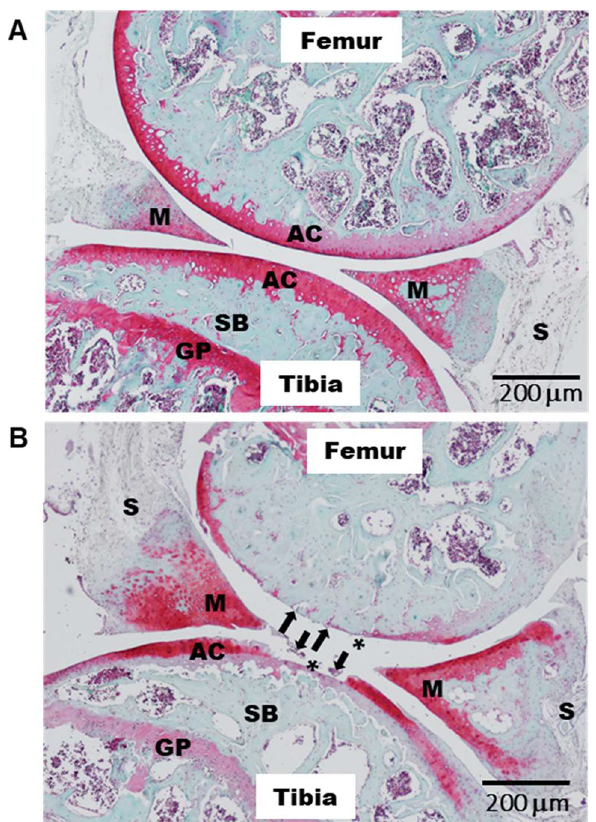
Figure 2. Characterization of in vivo mouse OA model with typical histological appearance: Representative haematoxylin-safranin-O-stained sections of knee from control ( A ) and DMM ( B ) mice respectively at 12 W after surgery. In ( B ), clear histopathological alterations: arrows indicate cartilage fibrillation, and asterisks indicate loss of cartilage. Scale bar: 200 µm; original magnifications 10×; AC, articular cartilage; M, meniscus; S, synovium; SB, subchondral bone; GP, growth plate.